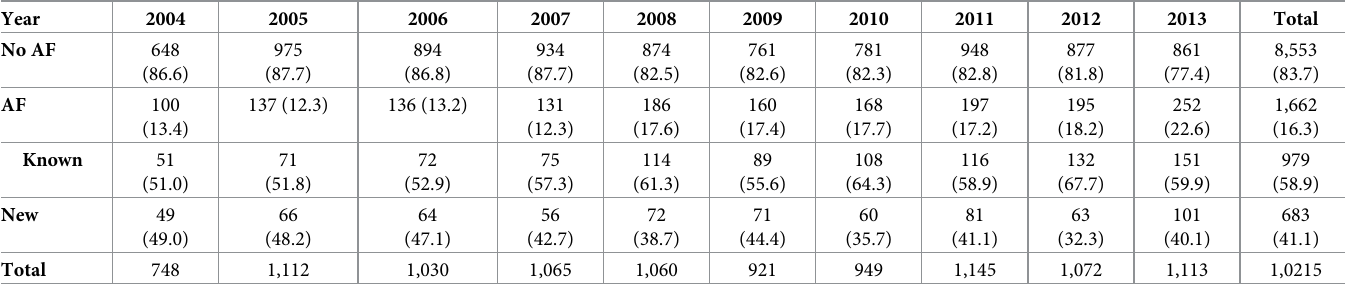
Table 2. Number of AIS patients with AF by year.